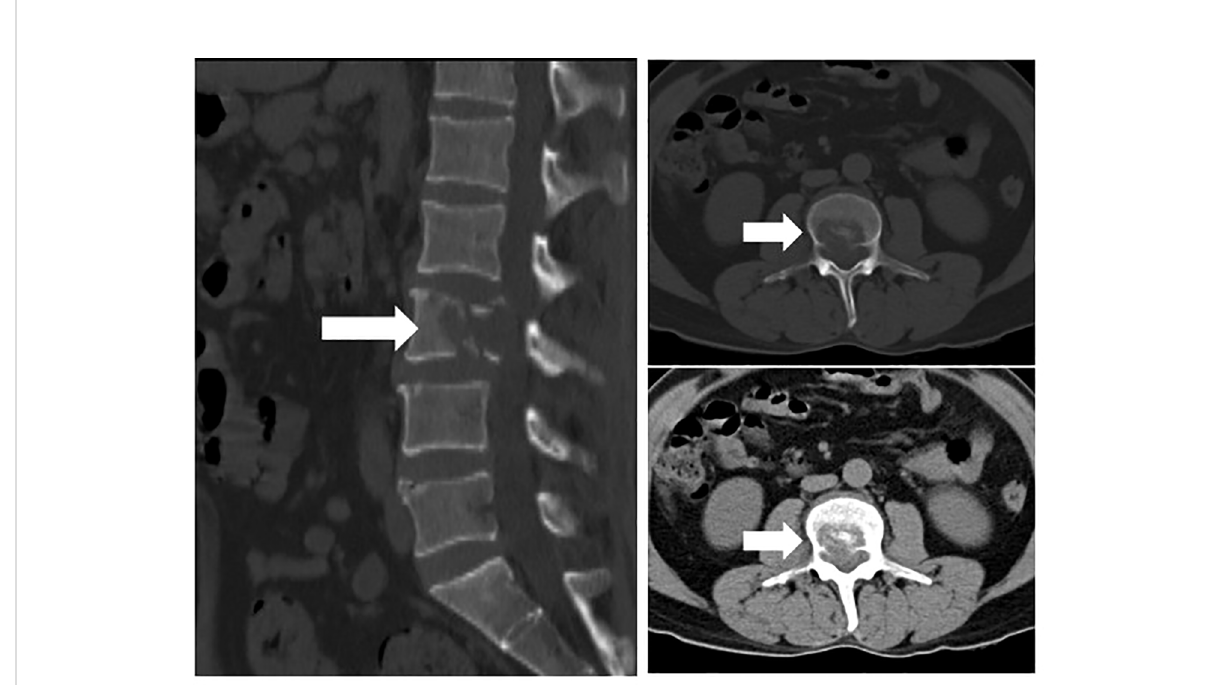
FIGURE 1 Bone destruction of the L3 vertebral body with abnormal low-density shadow within